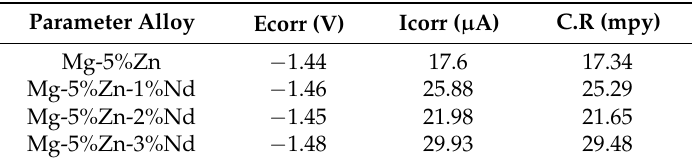
Table 4. Corrosion rate of tested alloys as obtained by Tafel extrapolation from potentiodynamic polarization curves.